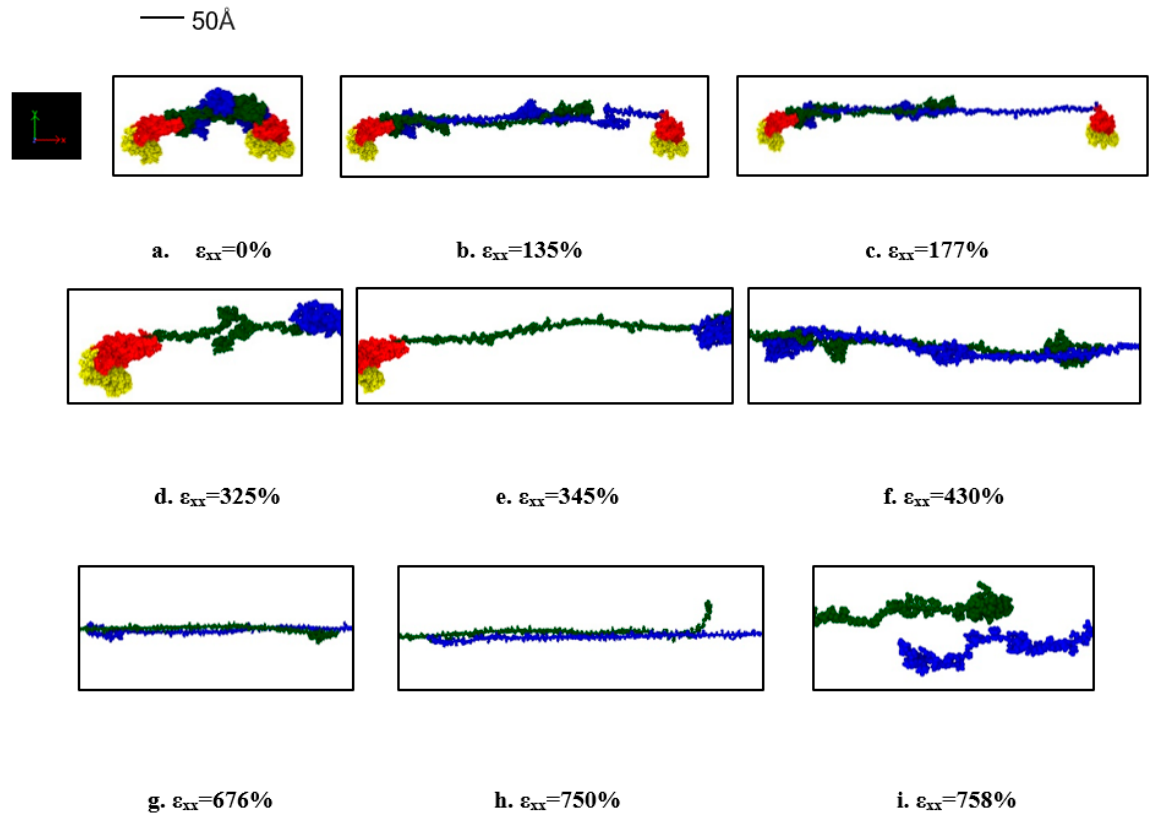
Figure 4. Stages observed during the pull of one protein in the dimerized tau model (for the strain rate of 2 × 10 9 s − 1 ). ( a ) Initial stage (strain: 0%), ( b ) Unfolding of protein 2 (strain: 135%), ( c ) Stretching of protein 2 (strain: 177%), ( d ) Unfolding of protein 1 (strain: 325%), ( e ) stretching of protein 1 (strain: 345%), ( f ) Disentanglement of the overlapped projection domains of the tau proteins (strain: 430%), ( g ) Continued disentanglement (strain: 676%), ( h ) Sliding out of projection domain (strain: 750%), ( i ) Separation of proteins (strain: 758%). Color legends: Green: Projection domain of protein 2, Blue: projection domain of protein 1, Red: MT binding region (including the inter-repeats) for protein 1 and 2, Yellow: N terminal tails of protein 1 and 2.